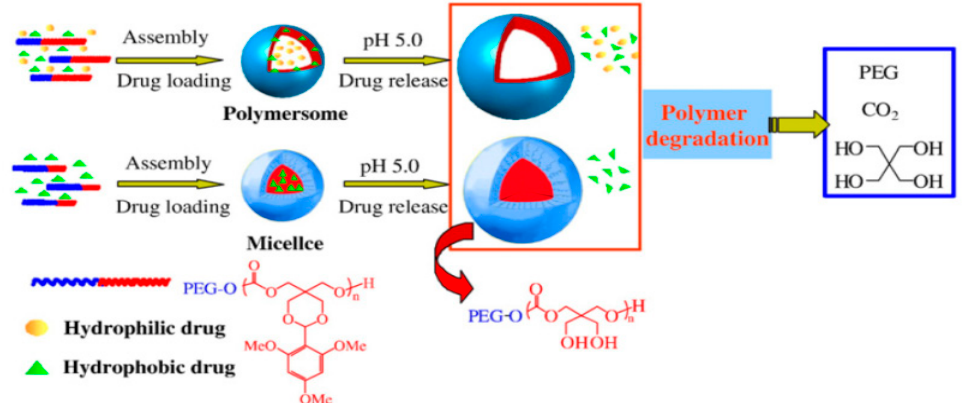
Figure 1. Schematic illustration of pH-sensitive degradable polymersomes or micelles based on poly((ethylene glycol)- b -(2,4,6-trimethoxybenzylidenepentaerythritol carbonate)) for triggered anticancer drugs delivery. Reprinted with permission from ref [70]. Copyright 2009 Elsevier B.V.